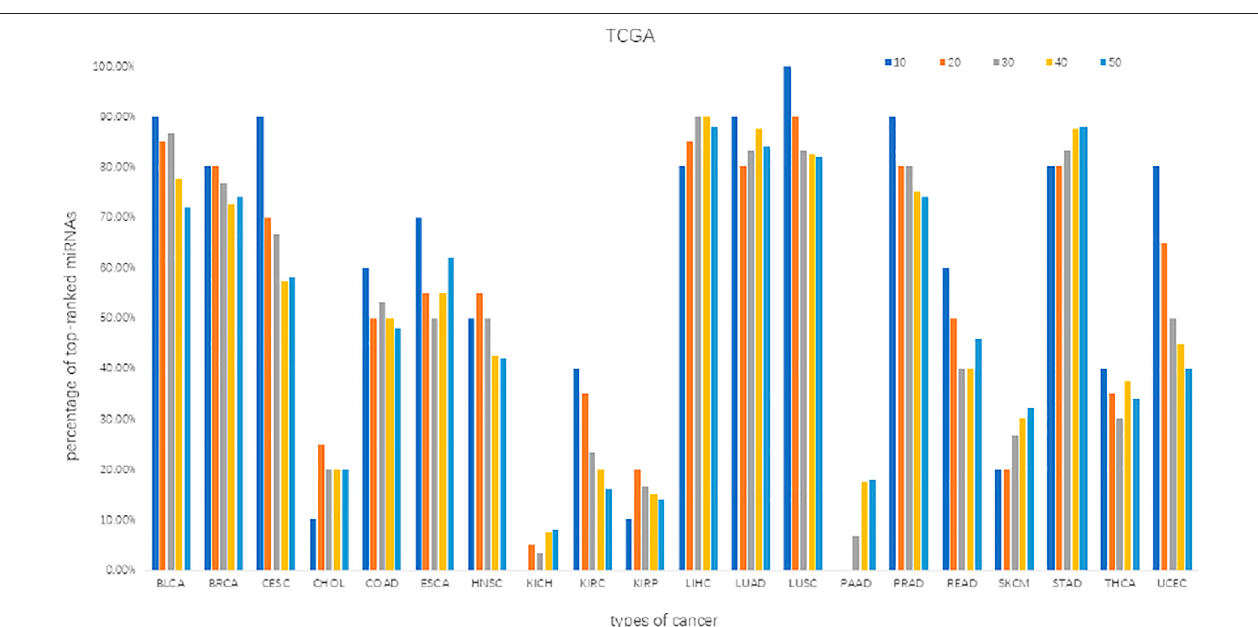
FIGURE 3 | The percentage distribution of top-ranked miRNAs screened from the datasets of 20 types of cancer.